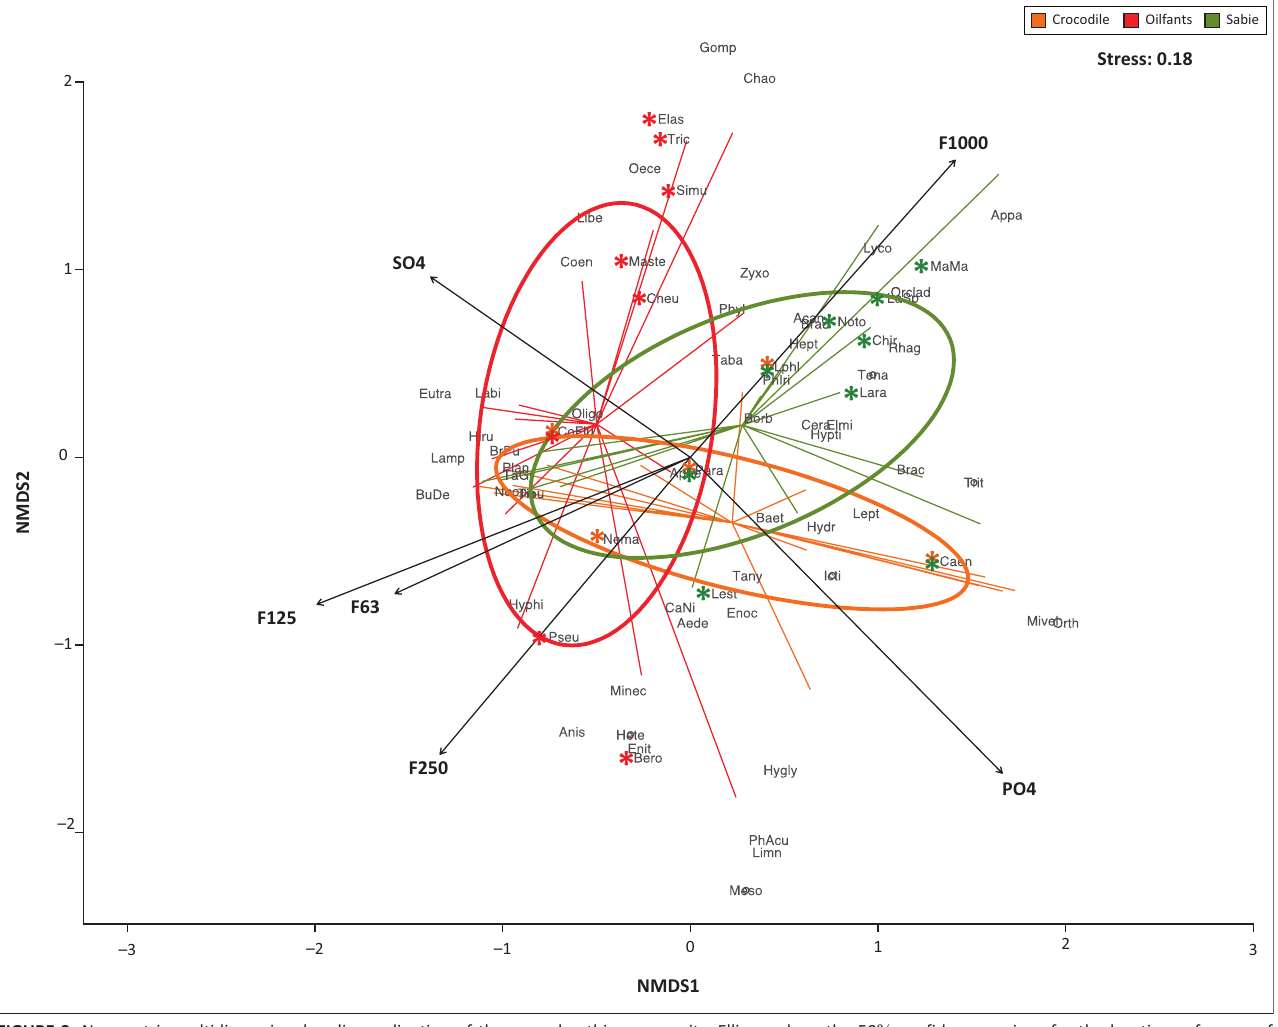
FIGURE 3: Non-metric multidimensional scaling ordination of the macrobenthic community. Ellipses show the 50 % confidence regions for the locations of group of samples’ centroids. ‘Spider webs’ show distances of samples to group centroids they belong. Species scores are directly ordinated on the biplot as text abbreviations (in Table 1-A1). Stars highlight taxa significantly associated with one or two river systems after multi-level pattern analysis. Environmental fitting was used to determine significant effects of environmental factors: the direction of vector showed the direction of the gradient, and the length of the arrow was proportional to correlation strength. Only significant environmental variables were displayed. Other abbreviations include NMDS, non-metric multidimensional scaling; PO4, concentration of phosphate in the water; SO4, concentration of sulphate in the water; F1000, fraction of sediment particles > 1000 µm; F250, fraction of sediment particles of